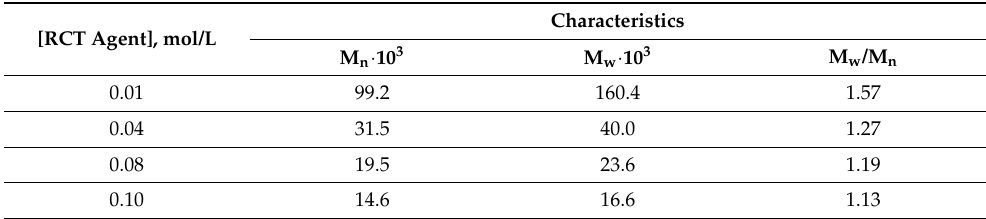
Table 1. Molecular-weight characteristics of PMAA synthesized in the presence of CDSPA, [AAD] = 0.002 mol/L, T = 70 ◦